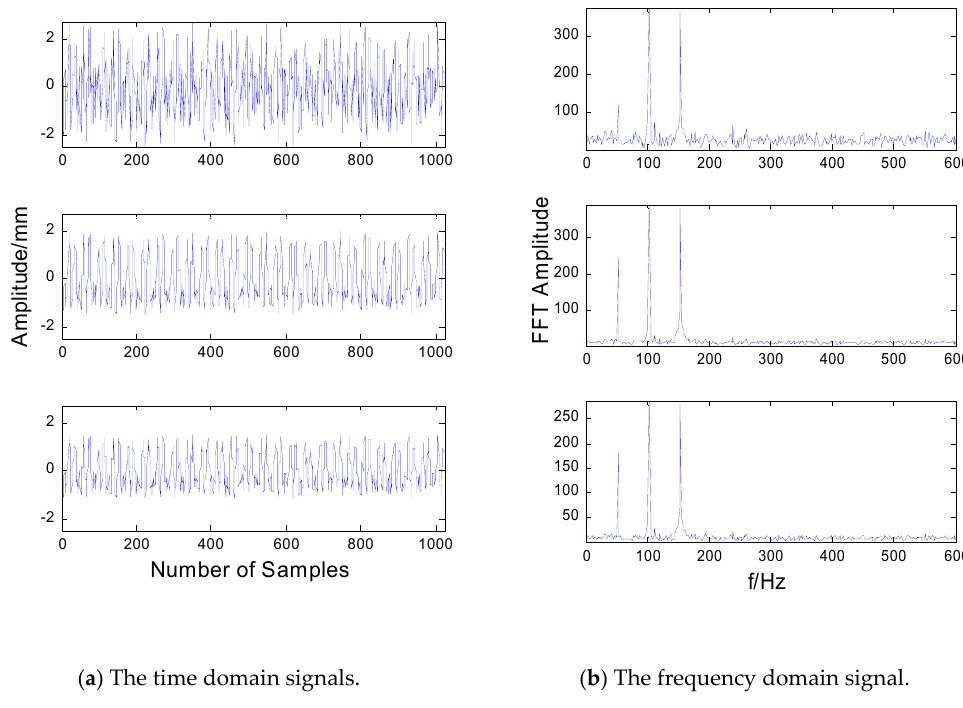
Figure 3. The time-frequency waveform of mixed Figure 3. The time ‒ frequency waveform of mixed signal.